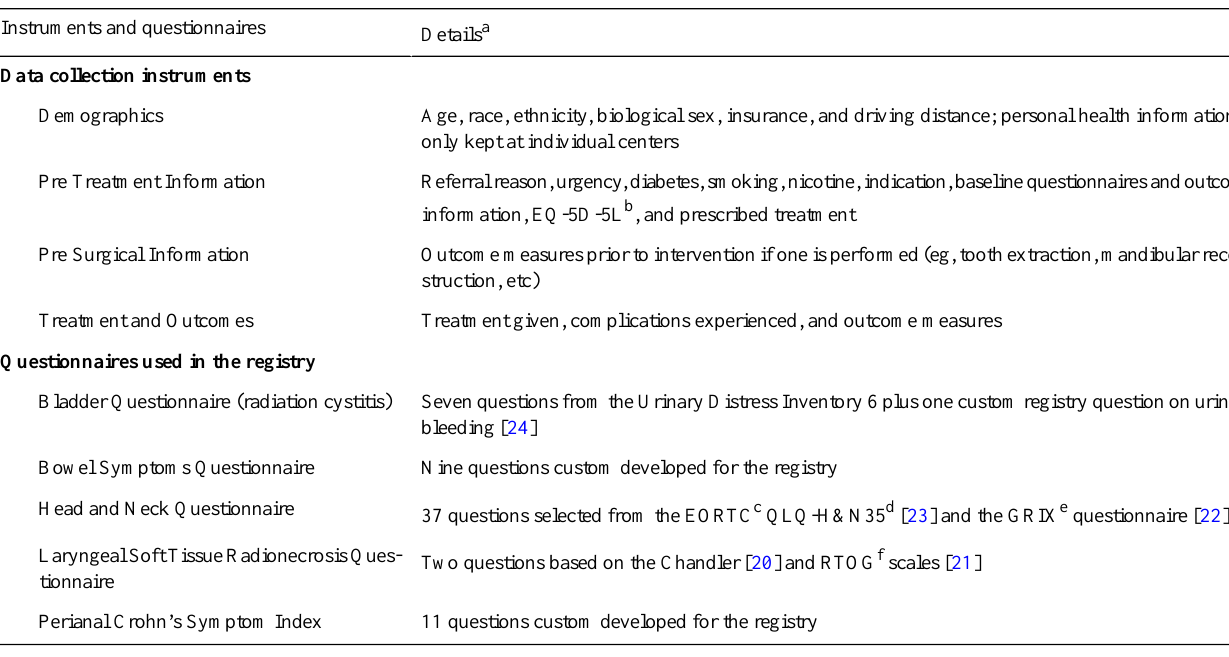
QLQ-H&N35: Quality of Life Questionnaire Head and Neck. e GRIX: Groningen Radiotherapy-Induced Xerostomia. f RTOG: Radiation Therapy Oncology